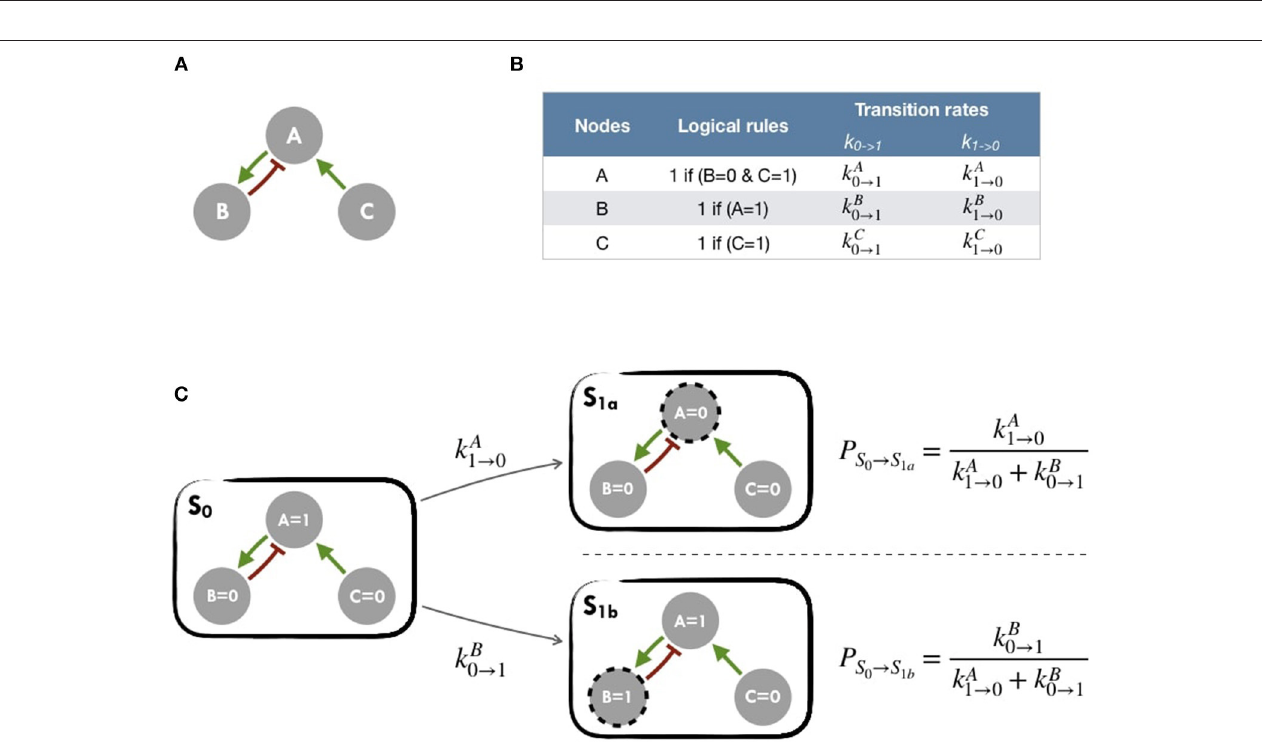
FIGURE 2 | Main principles of MaBoSS simulation framework and Gillespie algorithm (A) Toy model with B and C regulated by A. (B) In the first column, logical rules of the logical model: as an input A remains in its initial state; presence of A triggers B activation and C inhibition. In the second column, MaBoSS activation and inactivation transition rates are defined for each possible transition (C) In an asynchronous update scheme, starting from S 0 state, there are two possible following states S 1 a and S 1 b with their corresponding